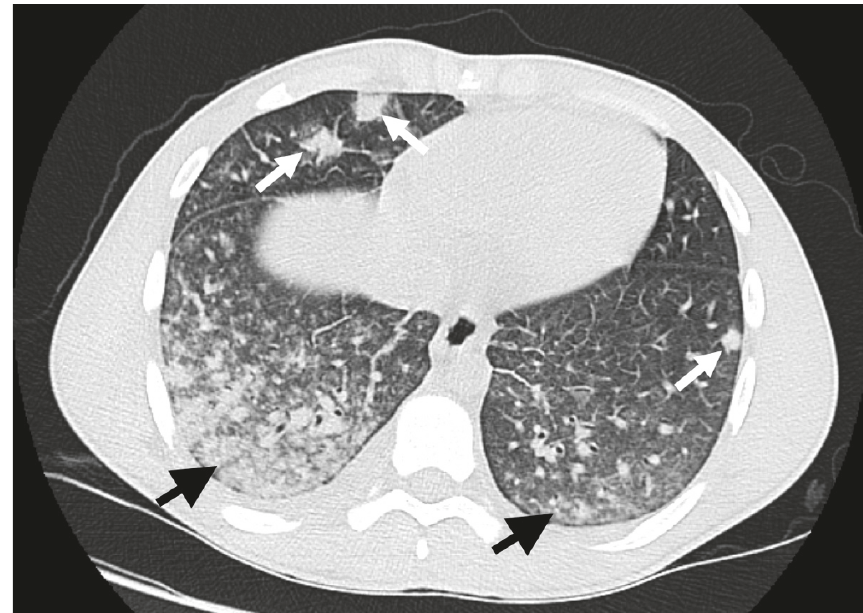
Figure 1: Axial image from CT scan of the chest without intravenous contrast. There are bibasilar patchy infiltrates, right greater than left (black arrows). There are additional scattered nodular opacities (white